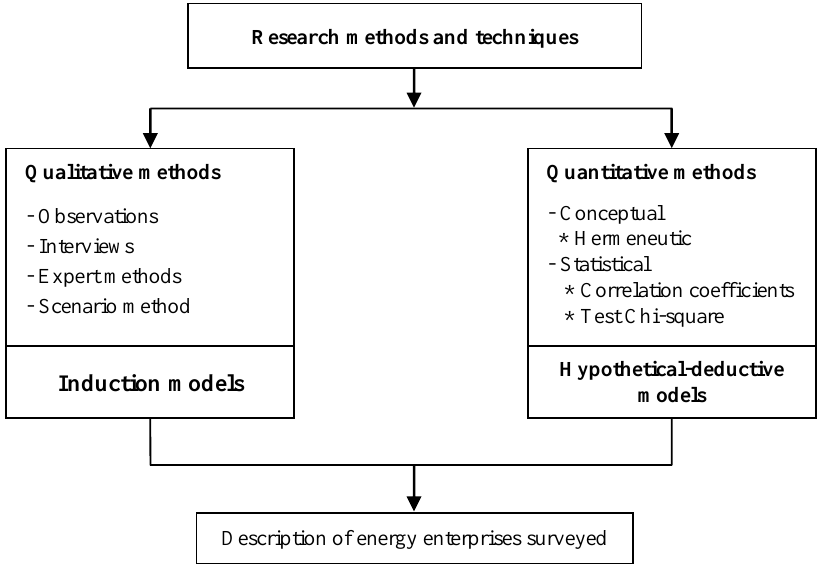
Figure 1. Research methods and techniques used in the